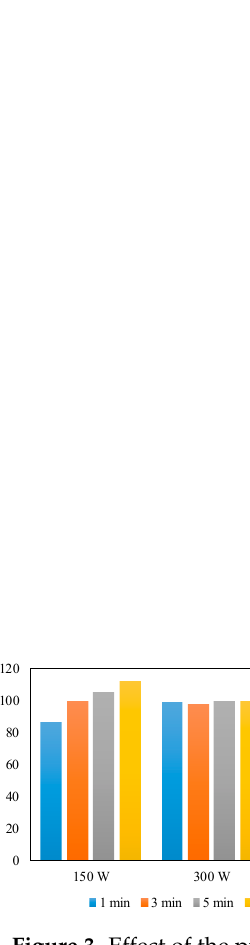
Figure 2. Effect of the process parameters on global yield: ( a ) time and power, ( b ) power and solvent, and ( c ) extraction time and solvent. Results expressed on a dry basis. Standard deviation by ANOVA = 0.6.